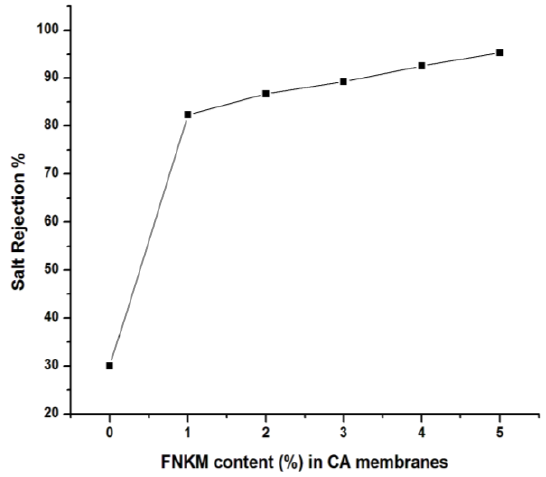
Figure 9. Correlation between FNKM loading content and salt rejection. Table 2. Cumulatively expressing performance of FNKM loaded CA membranes.